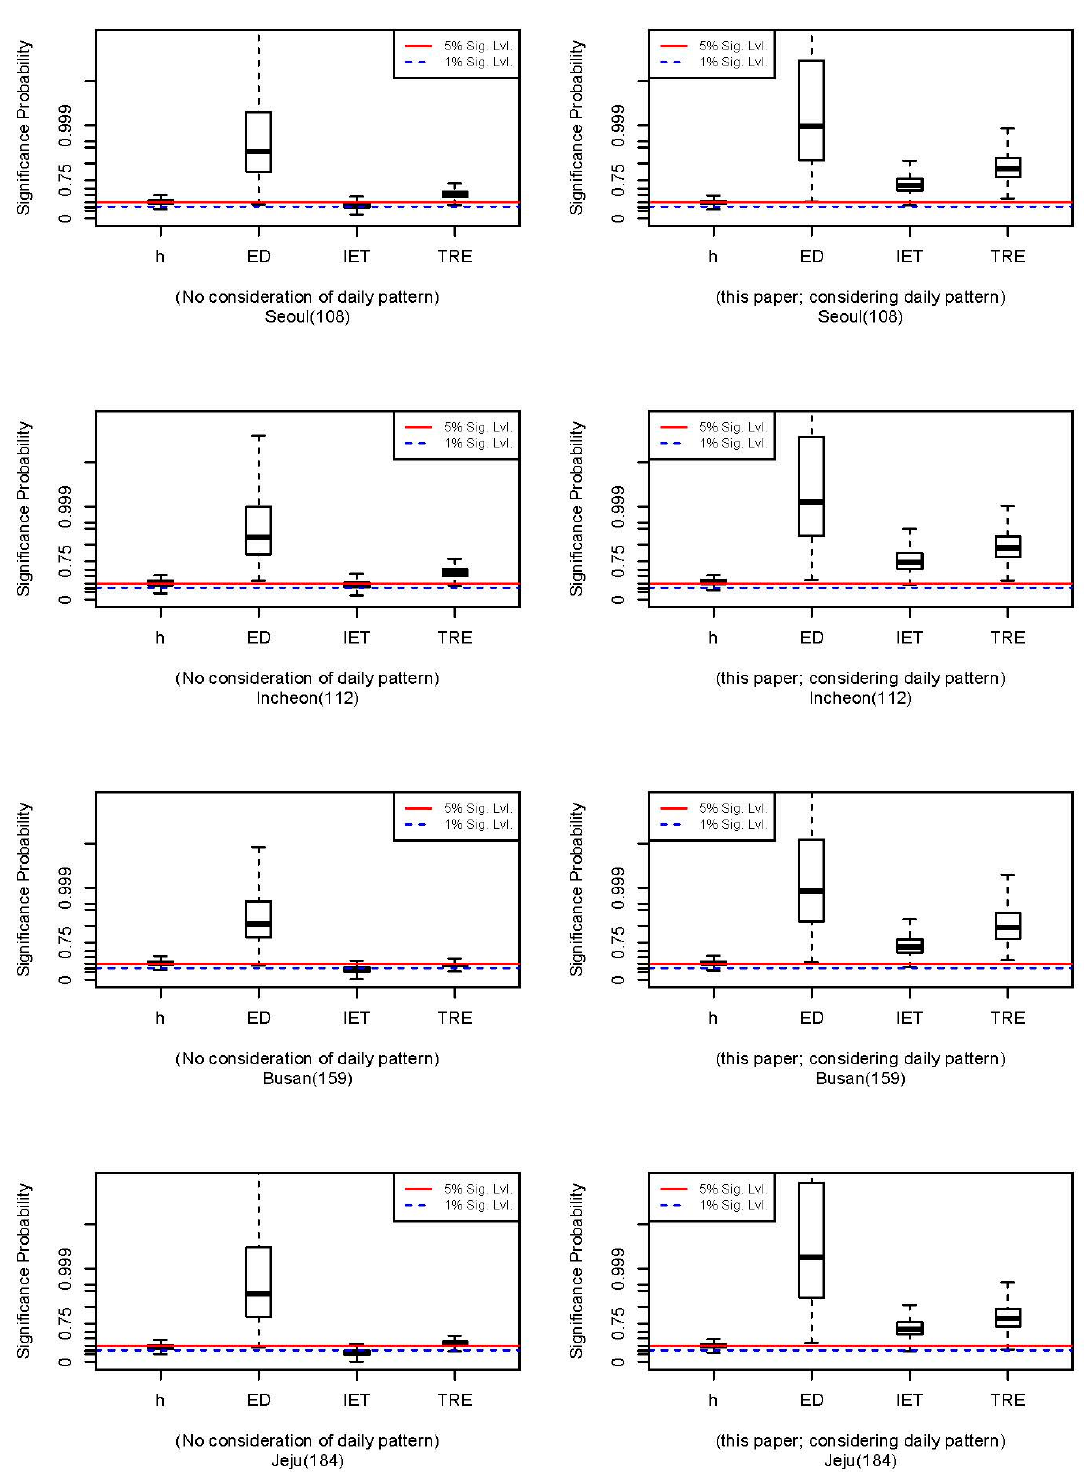
Figure 4. Distribution of p-values for rainfall event properties of original and the disaggregated hourly rainfall without ( left ) / with ( right ) three-day rainfall patterns under 5% and 1% significance level at the four rainfall stations (h: rainfall depth, ED: event duration, IET: inter-event time, and TRE: total amount of rainfall event), respectively.